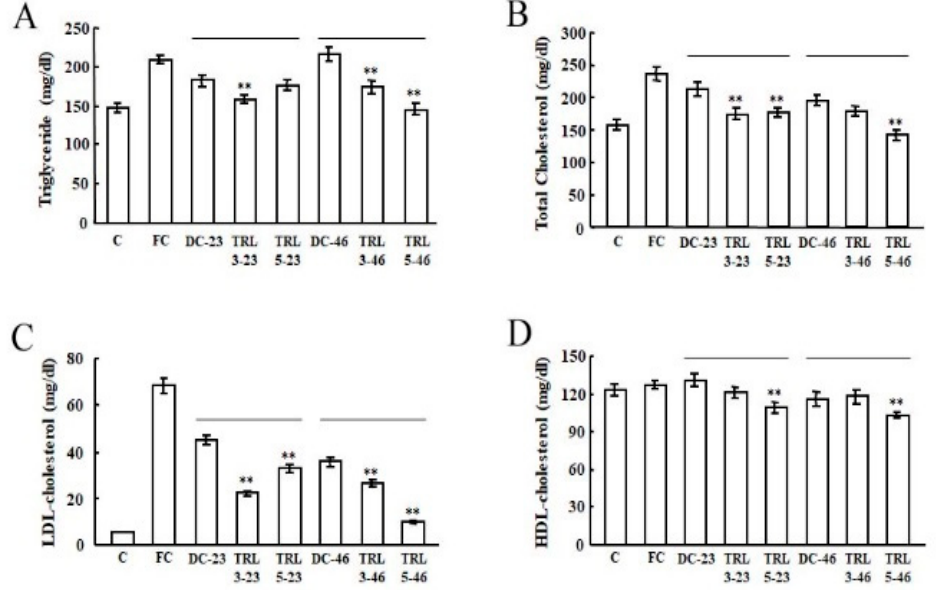
Figure 5. Effects of the transgenic rice on the lipid metabolism in the mouse sera. The levels of triglycerides ( A ), total cholesterol ( B ), high-density lipoprotein (HDL) cholesterol ( C ), and low-density lipoprotein (LDL) cholesterol ( D ) in the mouse sera were quantified after four weeks of the oral administration of the various experimental diets. The statistical significance was set to ** p < 0.01.